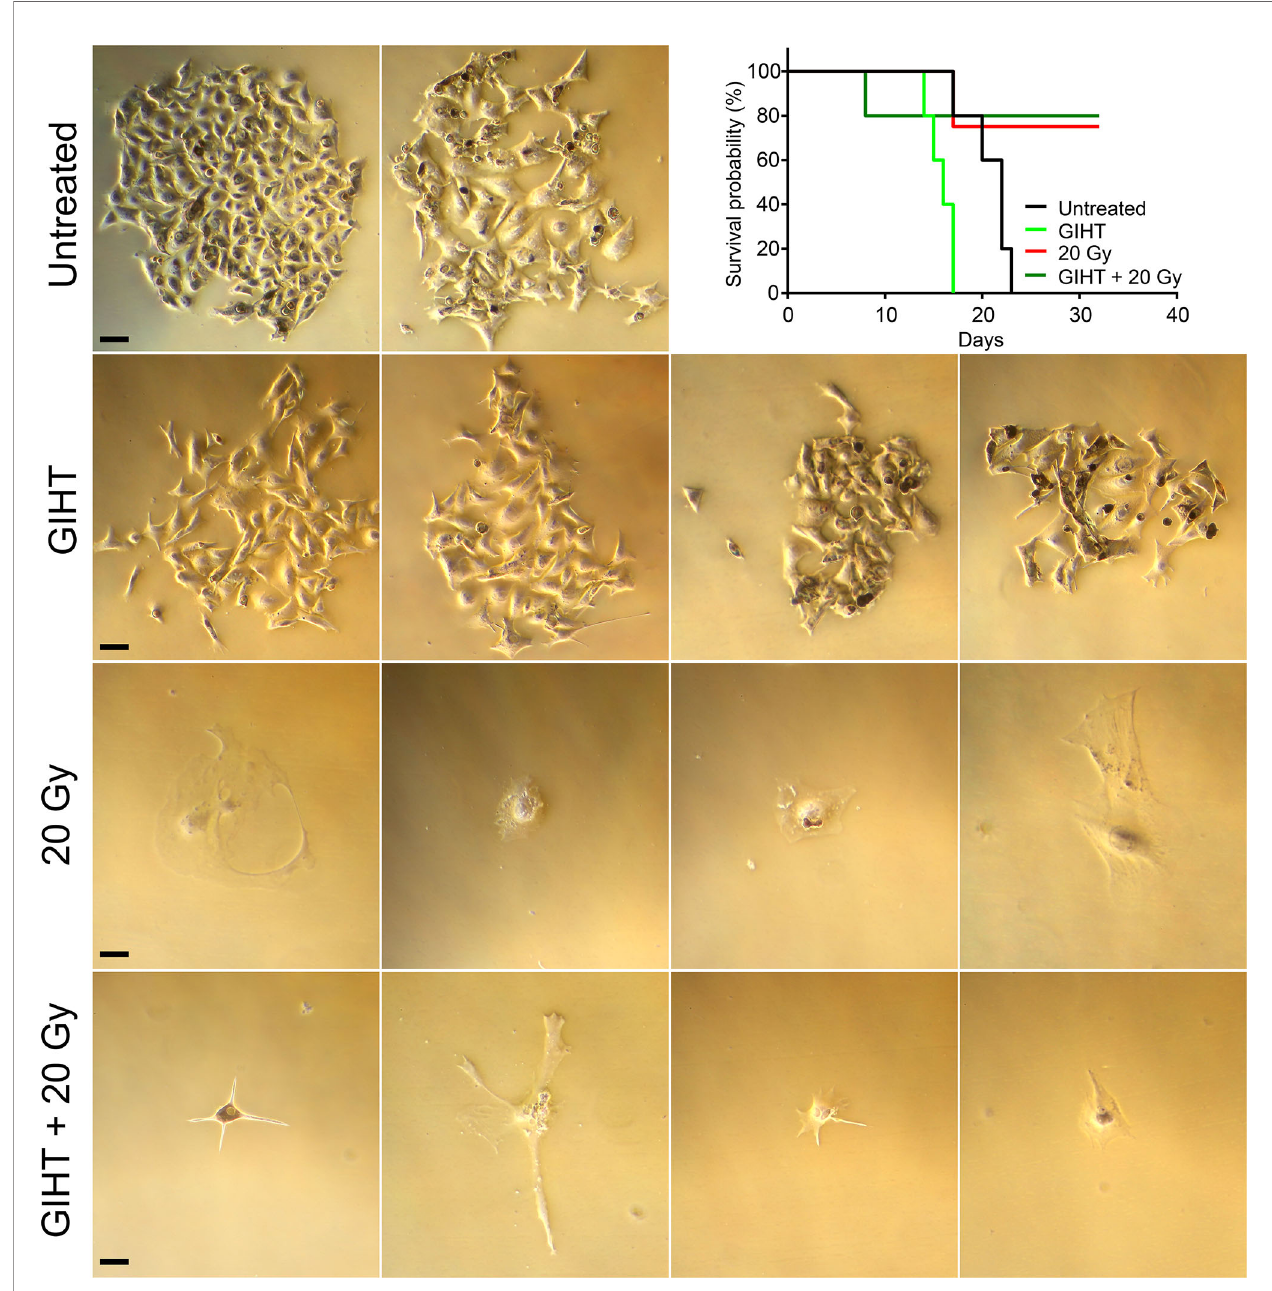
FIGURE 2 | Ef fi ciency of cell killing. B16F10 melanoma cells exposed to gamma irradiation (20 Gy), GIHT or the combination. Supernatants containing detached dead and viable cells were collected 24 hours post-treatment and cultured for further 7 days adding fresh medium twice. Representative bright fi eld pictures of cultures show growth of colonies after 7 days of treatment. Supernatants were also injected in the peritoneal cavity of C57Bl/6 mice. Mice were observed during 32 days or euthanized before if the growing tumor compromised their wellbeing. Kaplan-Meier survival analysis of mice (n=4 or 5) treated with the indicated supernatants. Scale bar, 25 µm. Gy, Gray; GIHT, graphene induced hyperthermia; i.p.